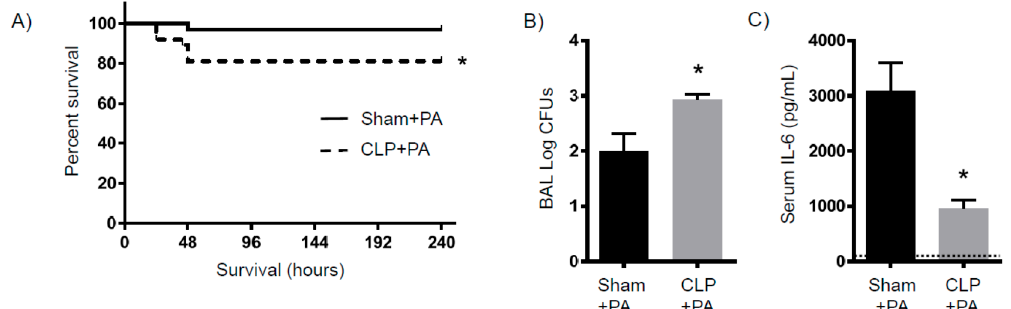
Figure 6. Response to pulmonary infection one week after CLP. Mice were subjected to either sham surgery or CLP. Eight days later, all mice were inoculated with 10 6 colony forming units (CFU) of Pseudomonas aeruginosa (PA) intranasally. Mice were then ( A ) monitored for survival (sham N = 32, CLP N = 37). In another set of experiments, mice were sacrificed and ( B ) the bronchoalveolar lavage (BAL) was analyzed for CFUs of bacteria 4 h after inoculation (sham N = 14, CLP N = 20). IL-6 levels in the ( C ) serum were measured at 2 h after inoculation by flow cytometry (sham N = 8, CLP N = 7). The dashed line indicates serum IL-6 levels in uninfected control mice. * p < 0.05 versus sham.